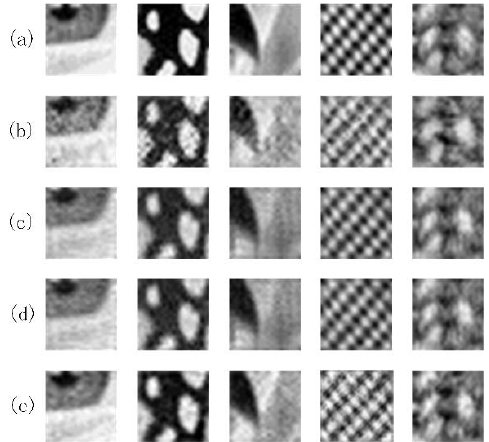
Figure 8. Imaging results of DAPA using different DIP reconstruction networks at 0.2 measurement rate, from top to bottom are ( a ) original image; ( b ) reconstructed by U_Net; ( c ) reconstructed by ( d ) reconstructed by Wdsr; ( e ) reconstructed by our DIP reconstruction network.